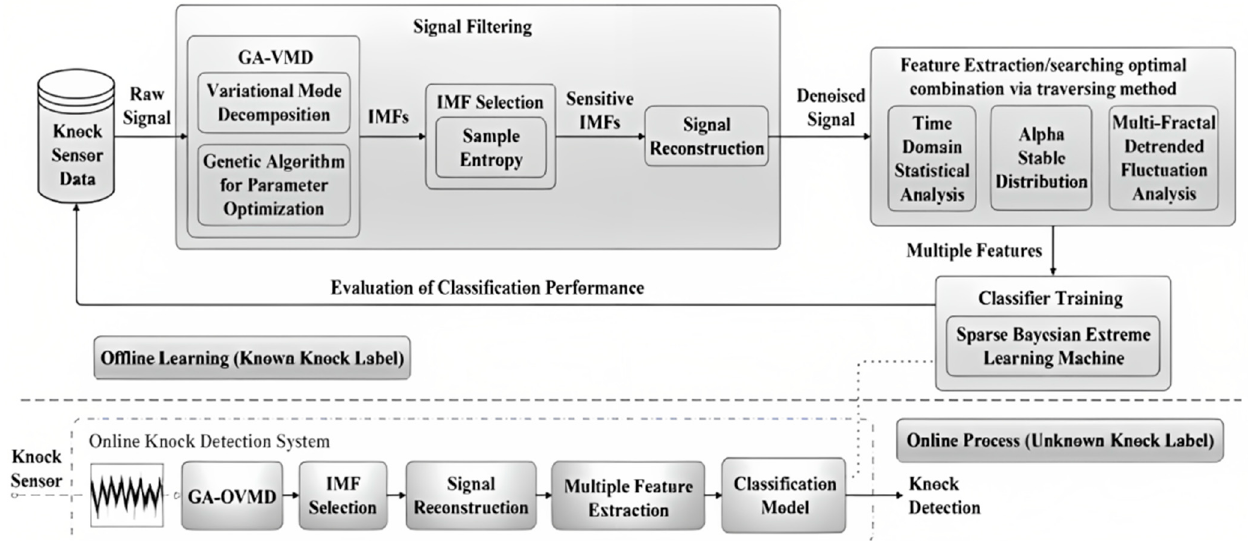
Figure 22. Engine knock detection framework and project workflow.